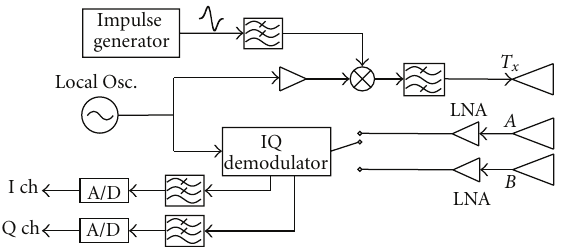
Figure 2: The block diagram of the prototype radar transmitter- receiver.